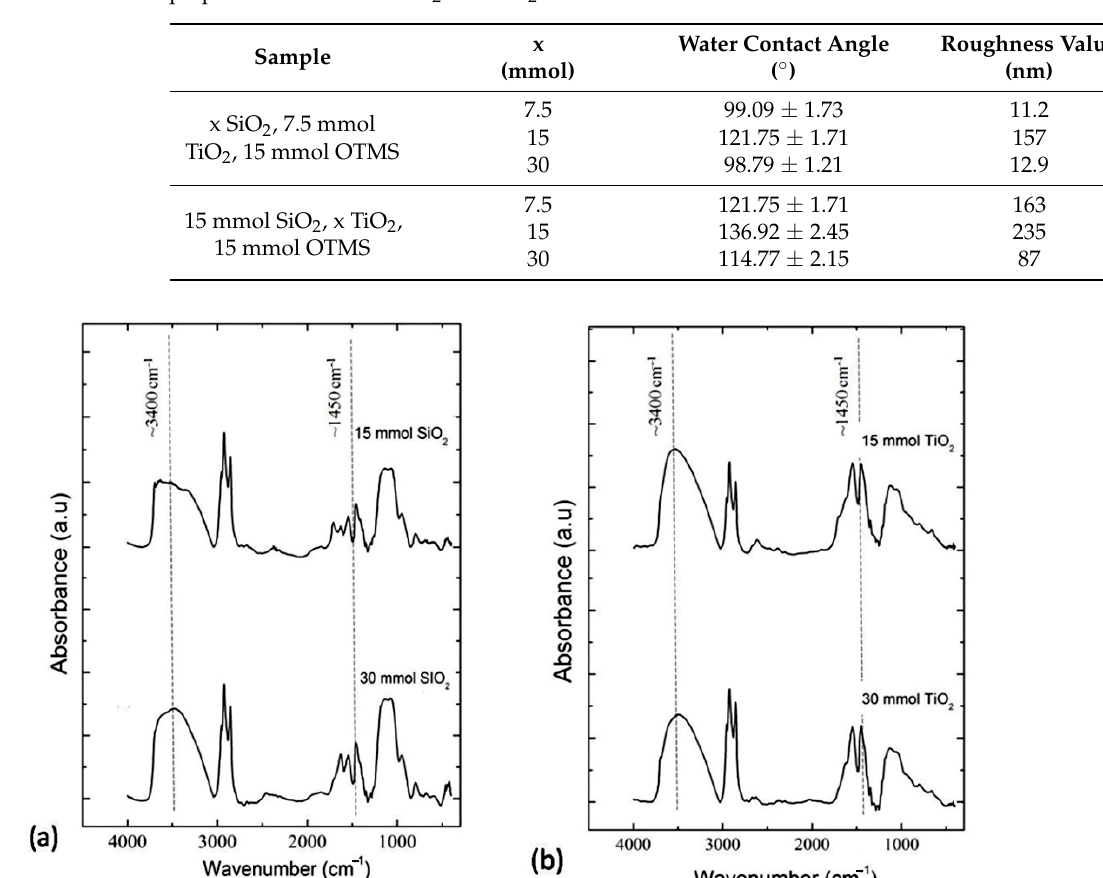
Table 1. The correlation of water contact angle and roughness value of SiO 2 -TiO 2 -OTMS coatings